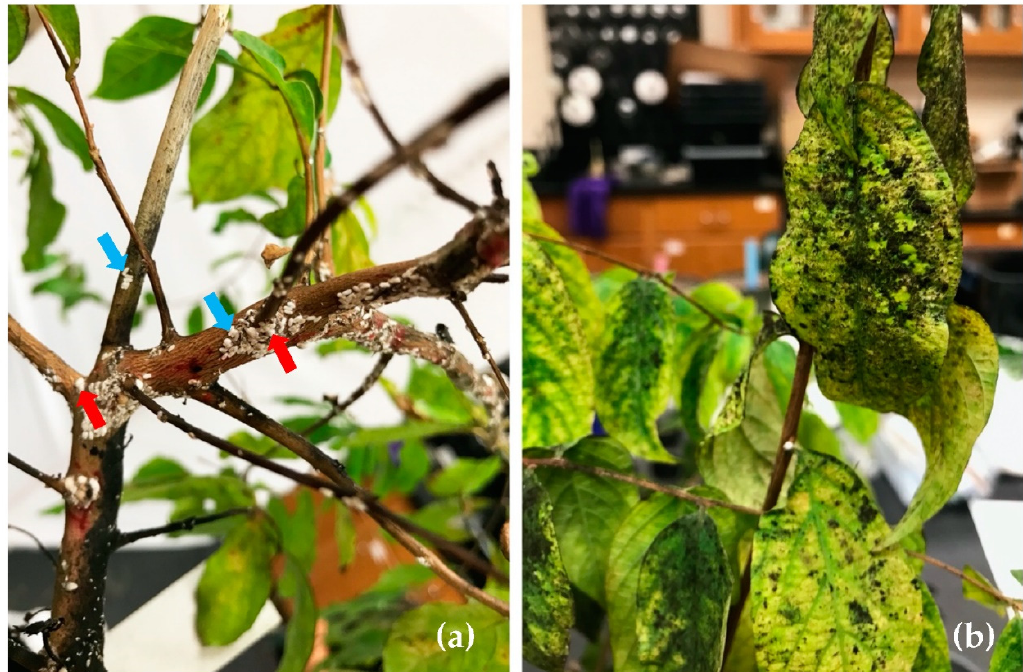
Figure 5. The infestation of CMBS occurred on Lagerstroemia subcostata and Lagerstroemia limii after inoculation. ( a ) Numerous CMBS males (blue arrows) and females (red arrows) developed on stems of L. subcostata, and black sooty mold accumulated on the bark 13 weeks after CMBS inoculation. ( b ) Black sooty mold accumulated on leaves of L. limii .